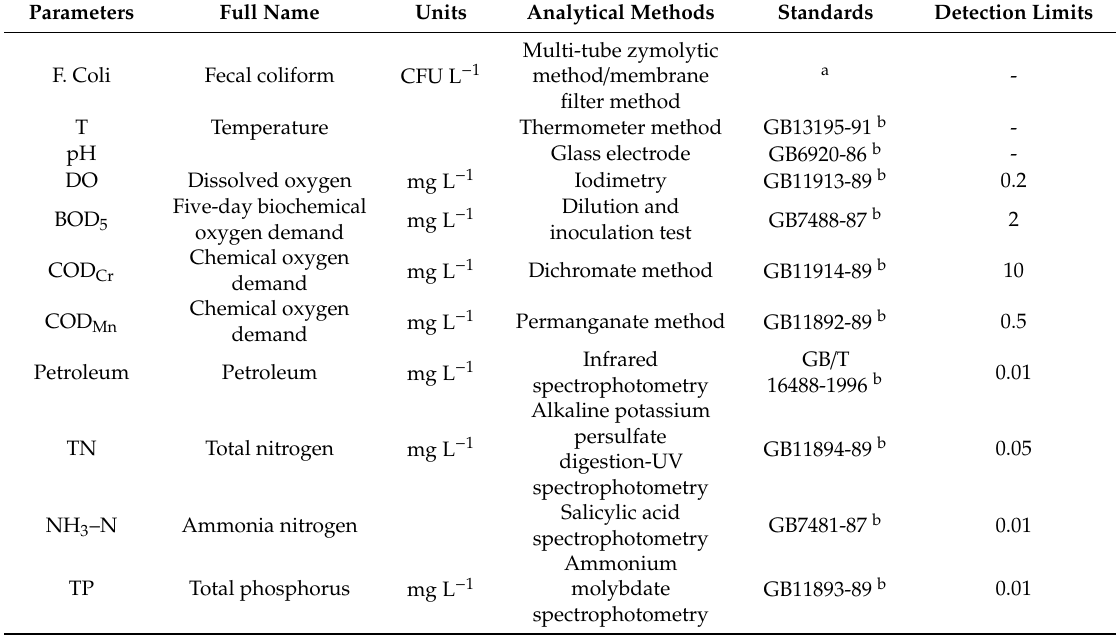
Table 1. Summary of the units, analytical methods and detection limits of di ff erent parameters in